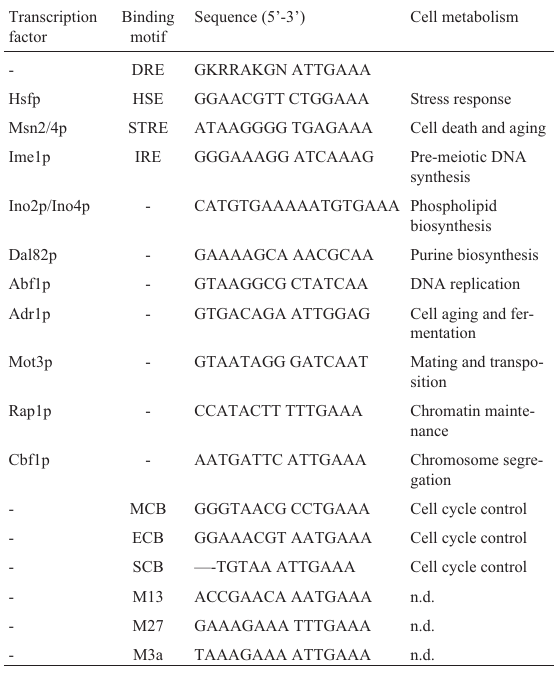
Table 4 - Motifs in the yeast genome homologous to the DRE